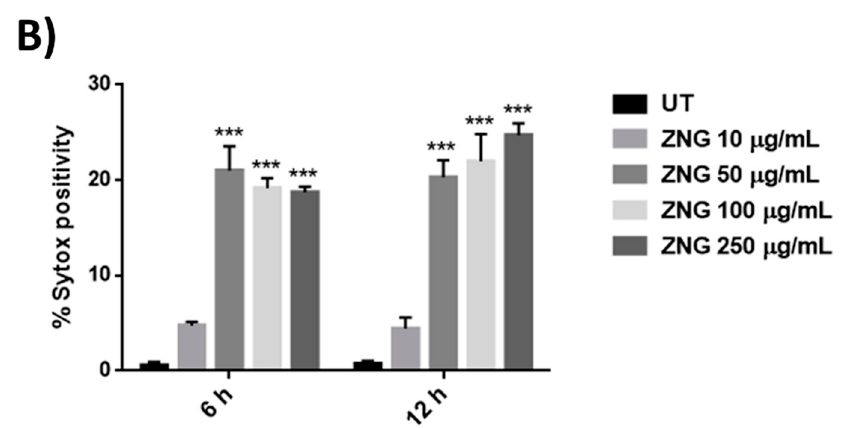
Figure 1. Viability of C. albicans treated with ZnO nanorods (ZNGs) material. ( A ) SYTOX Green staining of C. albicans cells exposed or not to ZNGs for 6 h or 12 h. Scale bar 5 µm; ( B ) Percentage of fluorescent died cells relative to the total cells. The data were analyzed by two-way analysis of variance (ANOVA), followed by Bonferroni’s test. (*** p < 0.001).